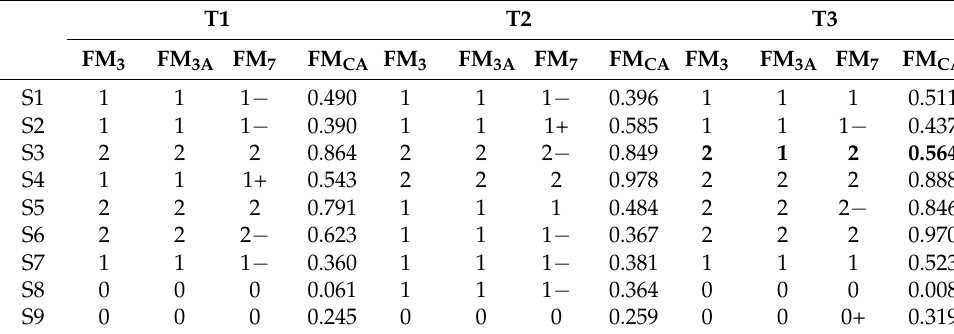
Table 8. Rated FM scores by clinician and implemented sensor-based system.